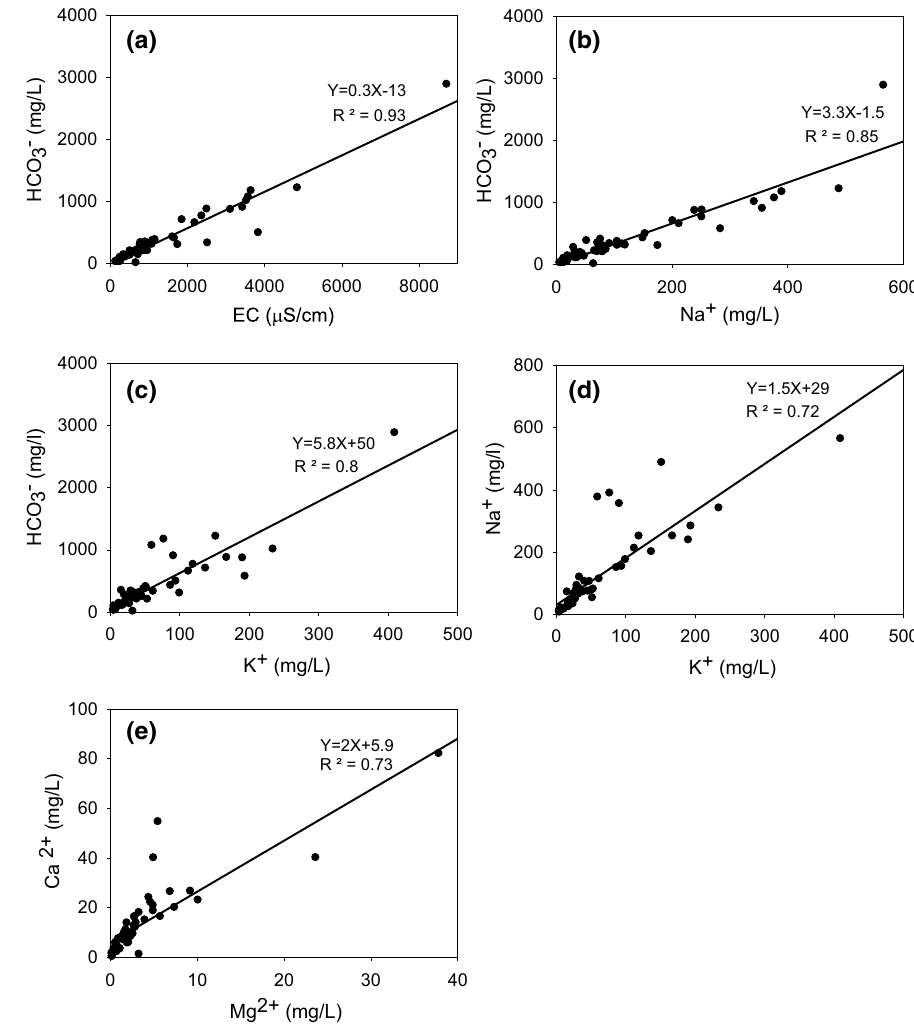
Fig. 10 Positive correlations of HCO 3− with: a EC, b Na + and, c K + . Other positive correla- tions of the paired cations are shown in d Na + with K + . and in e Ca 2+ with Mg